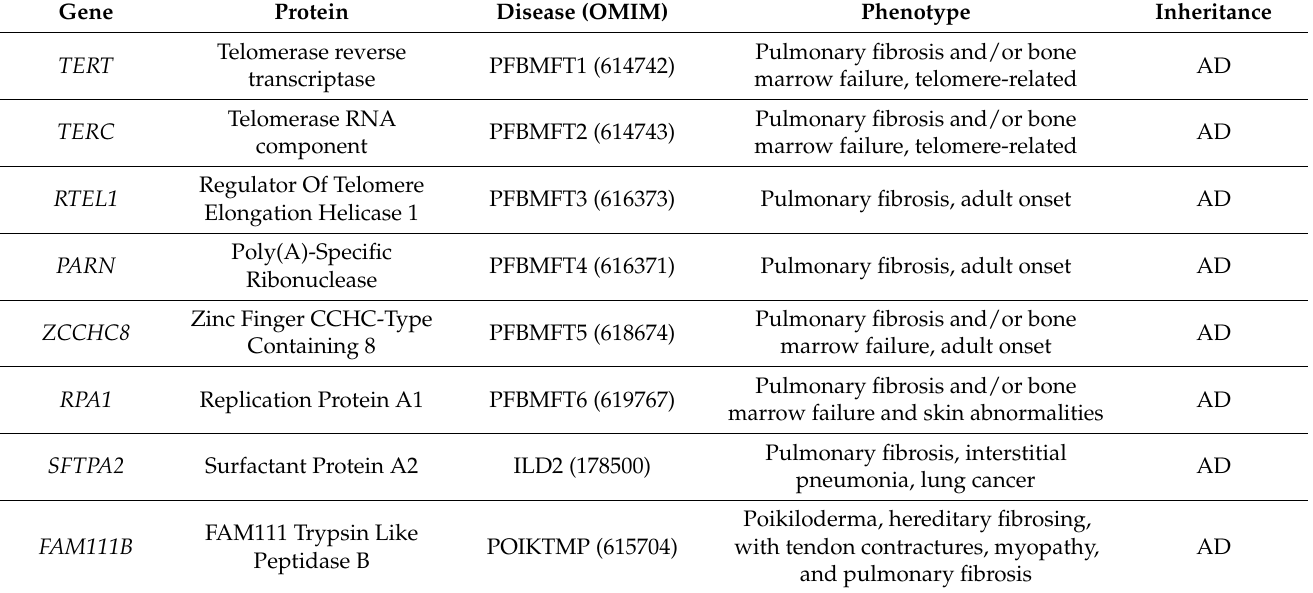
Table 1. Causative genes for FPF. The relative proteins, OMIM identifier, phenotype and type of inheritance are